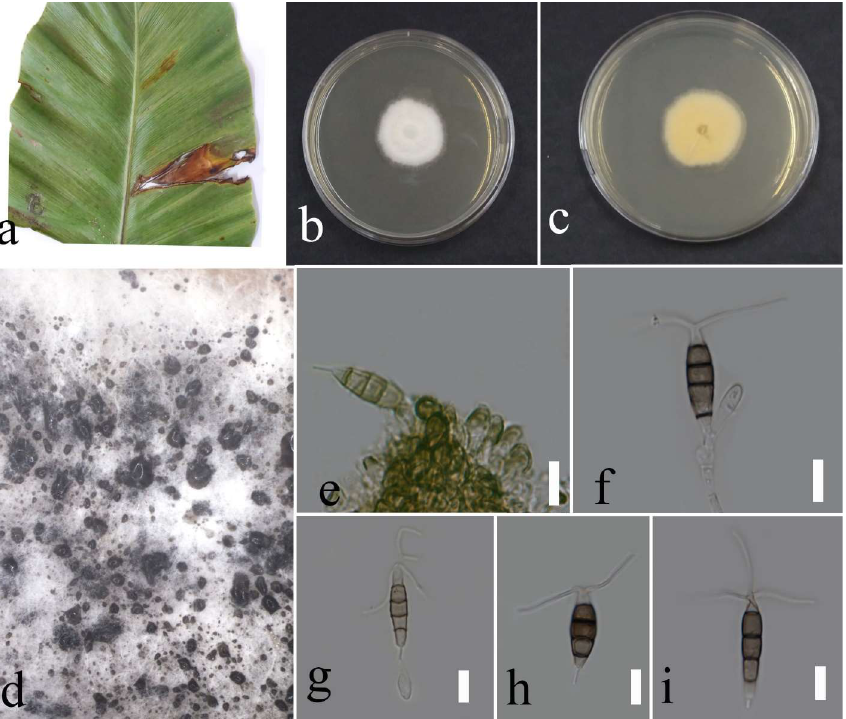
Figure 8. Morphology of Neopestalotiopsis musae based on the isolate MFLUCC 22 - 0162: ( a ) leaf spot in Asplenium nidus ; ( b , c ) upper and reverse views of the colony after seven days of growth on PDA at 28 °C; ( d ) conidiomata; ( e , f ) conidiogenous cells; ( g – i ) conidia . Scale bars = 10 µm . Neopestalotiopsis pandanicola Tibpromma & K . D . Hyde, 2018. Facesoffungi number: FoF 13403; Figure 9.